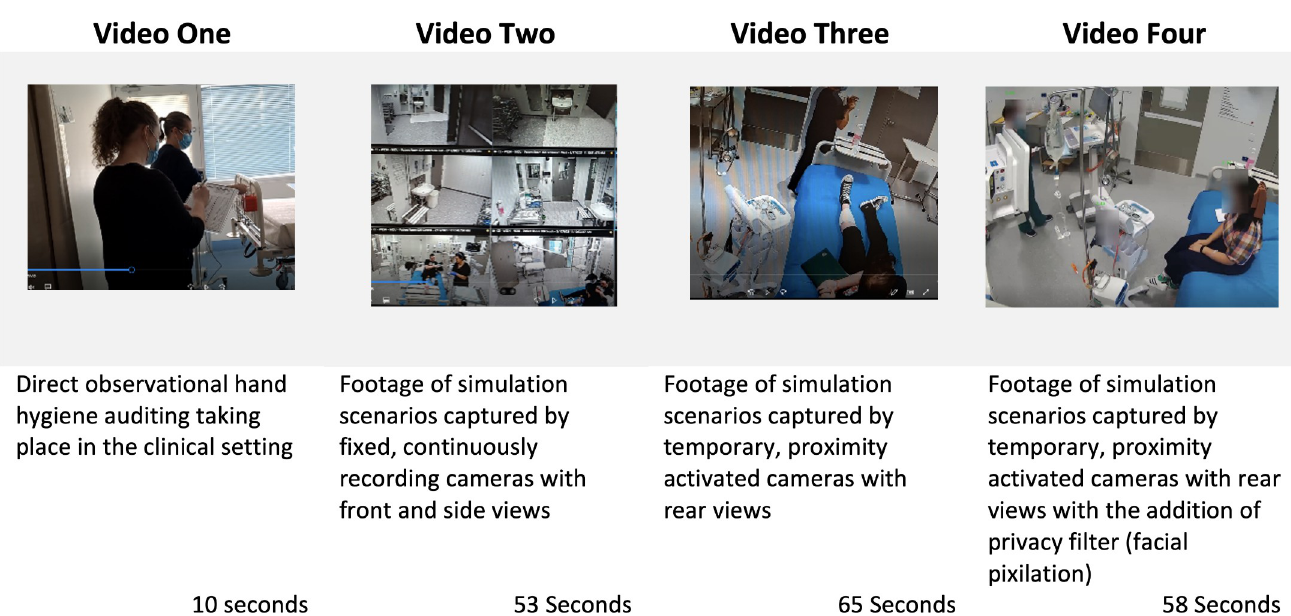
Fig 1. Videos shown to participants to demonstrate various data collection methods for hand hygiene